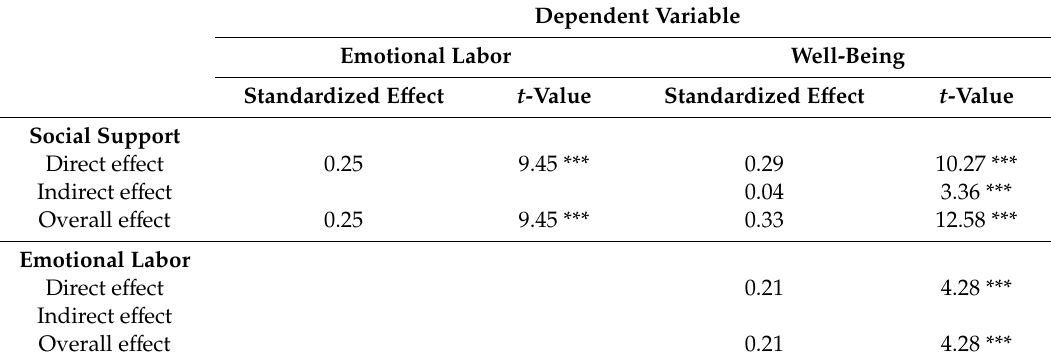
Table 4. Test of direct, indirect, overall e ff ect and